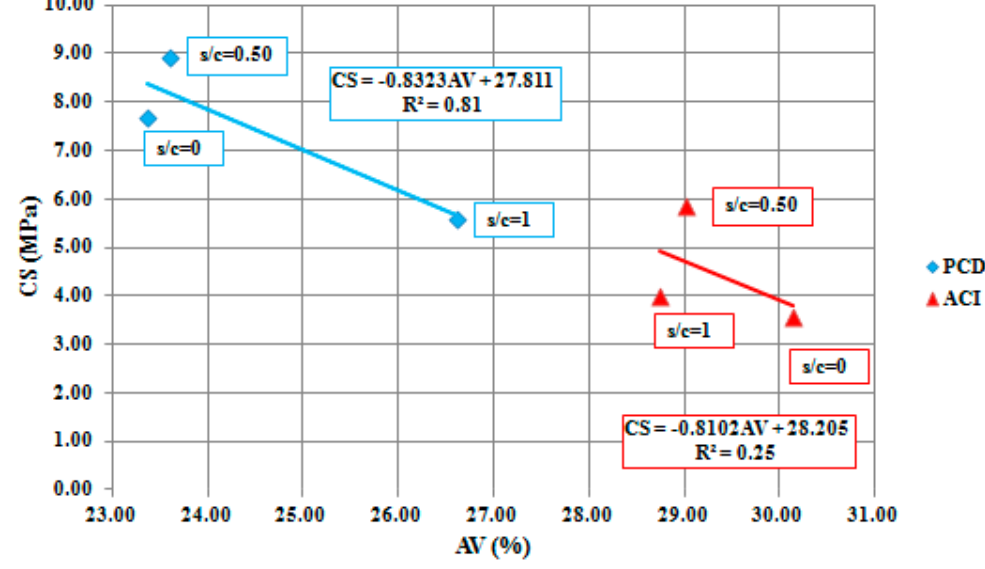
Figure 6. PCD and ACI 522R-10 methodologies linear regression and compressive strength (CS) model.